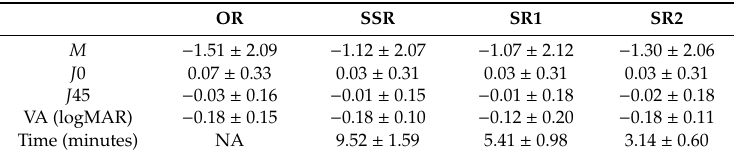
Table 1. Descriptive statistics from the di ff erent refraction procedures. OR SSR SR1